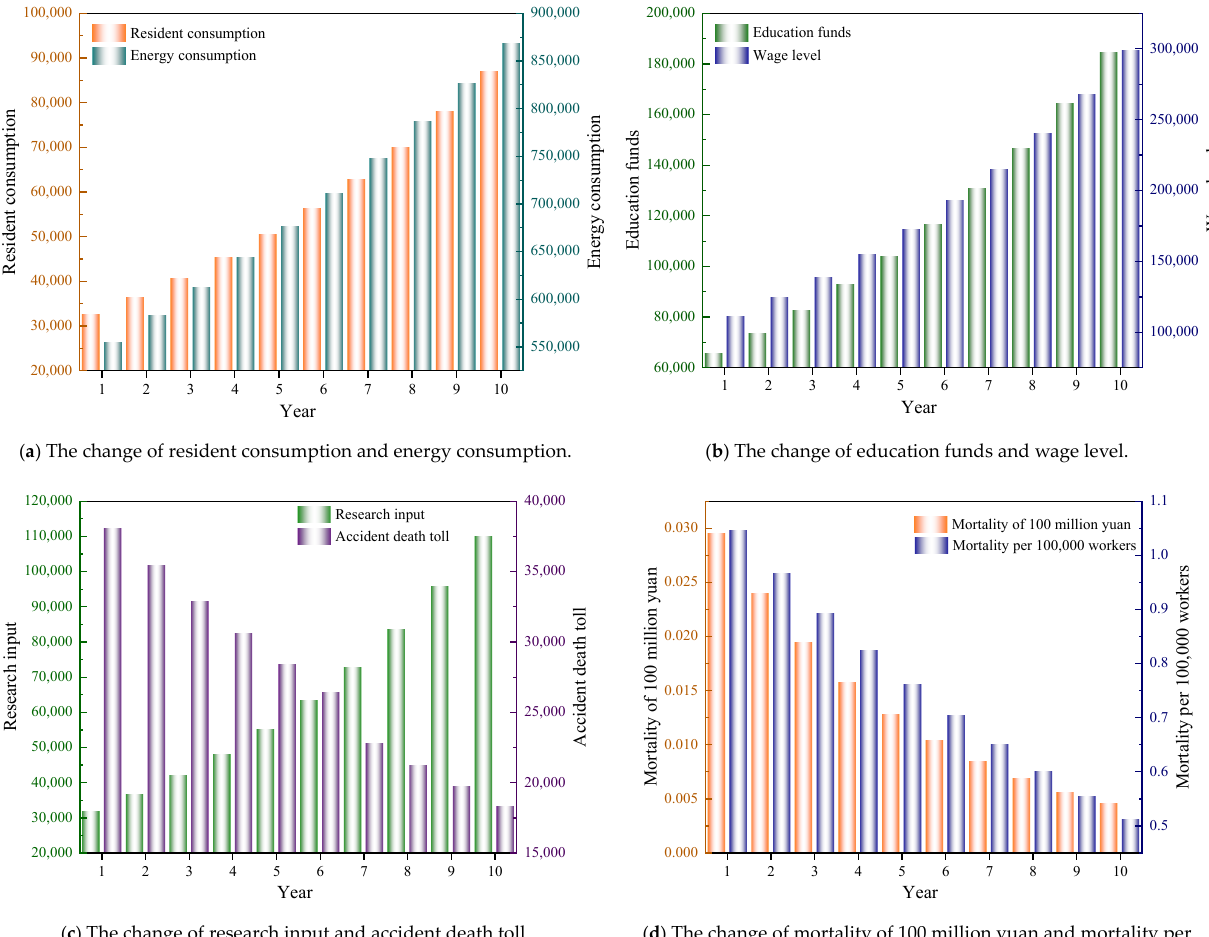
Figure 8. The change of economic indicators and accident indicators.